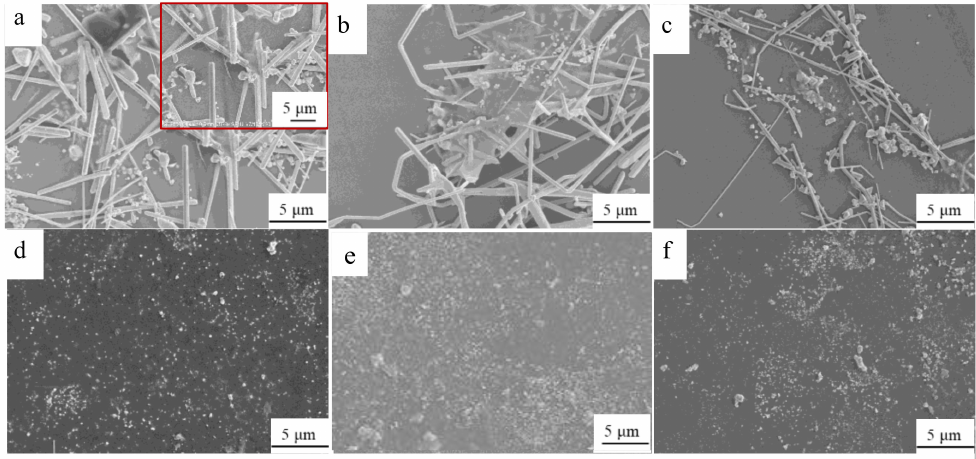
1:7.3 (Figure 2f) at 160 ◦ C for 3 h. The inset in Figure 2a is local magnification. As shown in Figure 2, when the mass ratios of GO:AgNO 3 in the reaction solution are 1:98.5 and 1:48.9, the products are mainly AgNWs-RGO composites, and graphene sheets cover the surface of AgNWs and fill the area between the AgNWs; when the mass ratio of GO:AgNO 3 is 1:32.4, the amount of silver nanoparticles in the product increases significantly, and the AgNWs become thin; when the mass ratios of GO:AgNO 3 are 1:15.7, 1:10.1, and 1:7.3, the products are hybrid composites of silver nanoparticles and graphene sheets. As the reaction temperature increases, the amount of the silver nanoparticles in the product increases, and the size of AgNWs decreases. As the reaction time increases, the size of AgNWs in the product decreases, and the number of AgNWs increases. More information about SEM images of the products synthesized under different reaction temperatures and times are shown in Figures S1 and S2 of the Supplementary Materials.